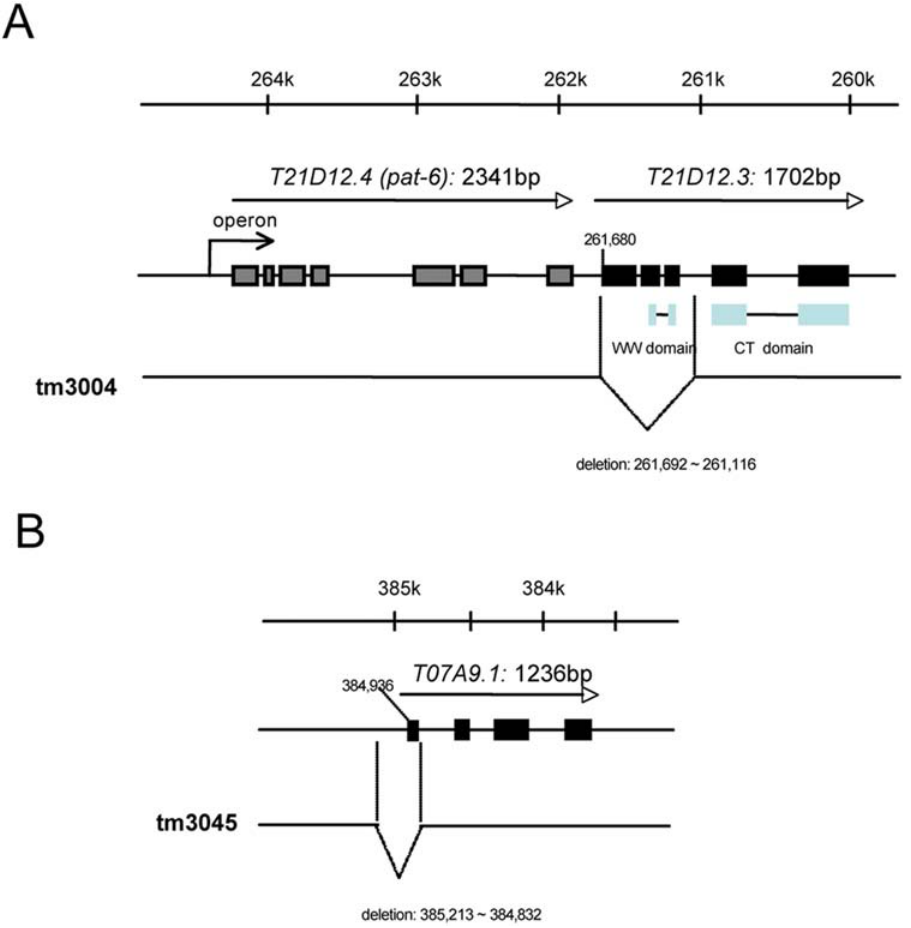
Figure 5. Generation of T21D12.3 -specific and T07A9.1 -specific mutant nematodes. A) T21D12.3 is the strictly conserved homologue of mammalian PQBP1 possessing WW domain and C-terminal domain. The genome maps show deleted regions in the genome of T21D12.3 and T07A9.1 mutants. B) T07A9.1 possesses a homology only to C-terminal domain of PQBP1 and does not possess WW domain. The genome maps show deleted regions in the genome of T07A9.1